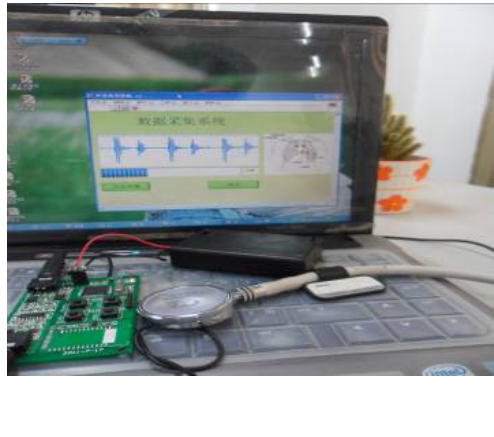
Figure 7. Equipment for signal acquisition.